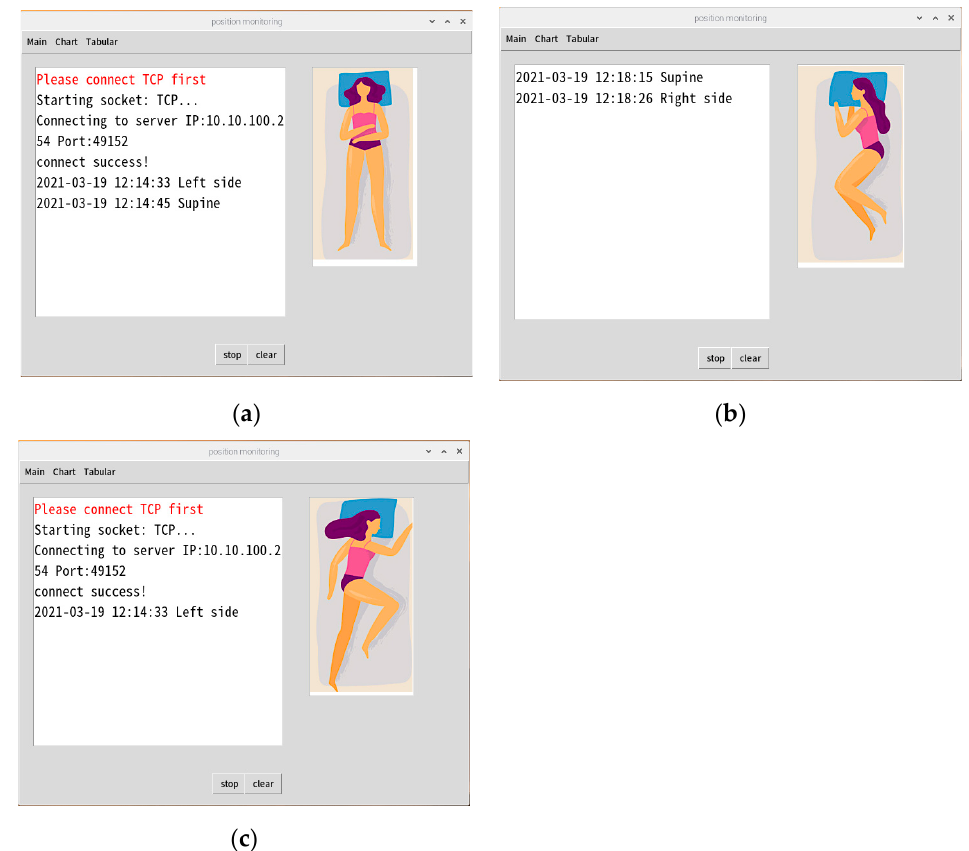
Figure 3. Graphical user interface (GUI) results of the Raspberry Pi for ( a ) a supine position, ( b ) recumbent right, and ( c ) recumbent left.